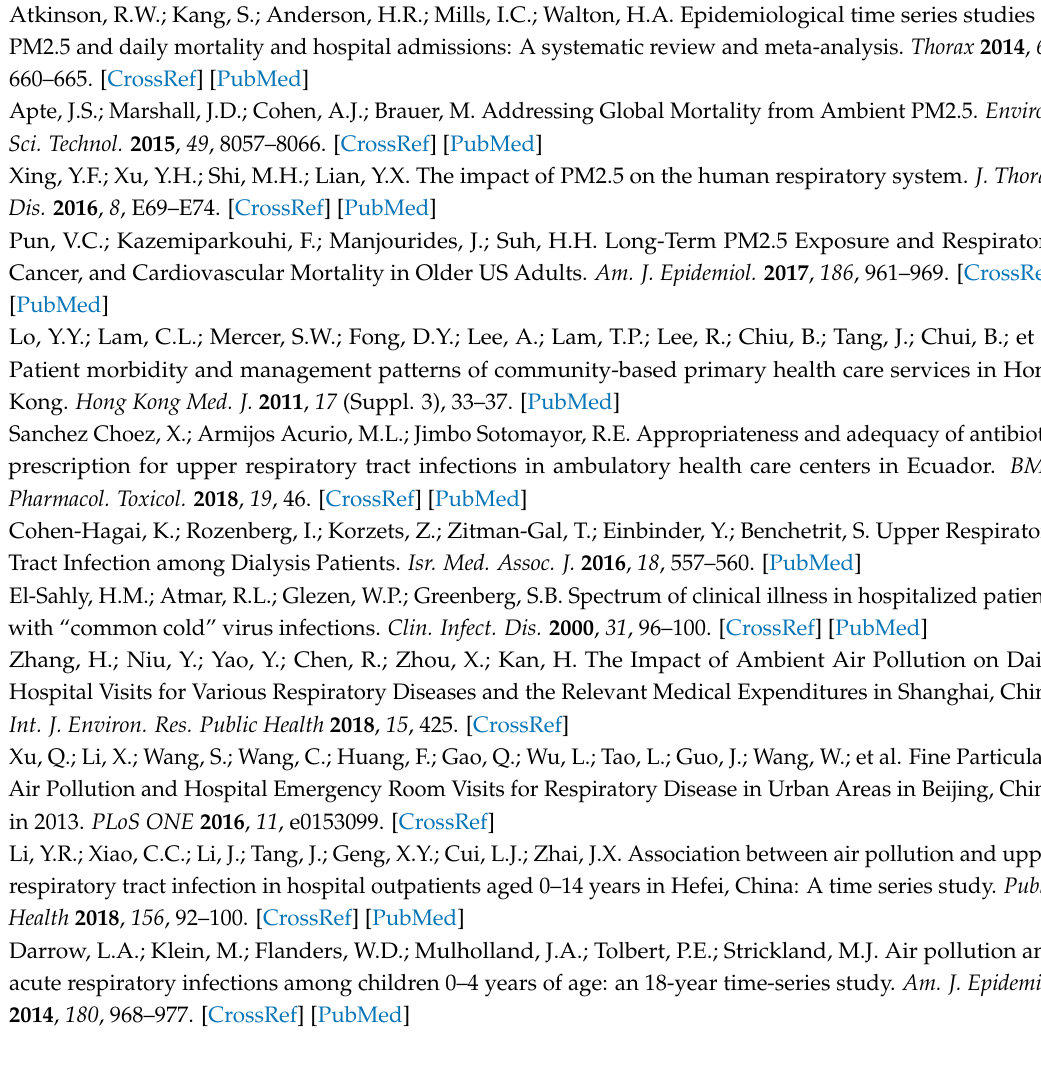
Figure S1: The exposure–response curve of fine particulate matter (PM 2.5 ) concentrations at lag 3 days and hospital admissions for URTI between 1 October 2010 and 30 September 2012 in Beijing, China. Note: The x -axis is the PM 2.5 concentrations (mg/m 3 ) at lag 3 days. The y -axis is the predicted log (relative risk (RR)). The curve, after adjusting for temperature, relative humidity, day of week, public holiday, and calendar time, is shown by the solid line, and the dotted lines represent the 95% CI. Table S1: Percentage change with 95% CI in all three kinds of hospital utilizations for URTI related to a 10 µ g/m 3 increase in fine particulate matter (PM 2.5 ) level at lag 3 days, by different degree of freedom ( df ) for calendar time, temperature, and relative